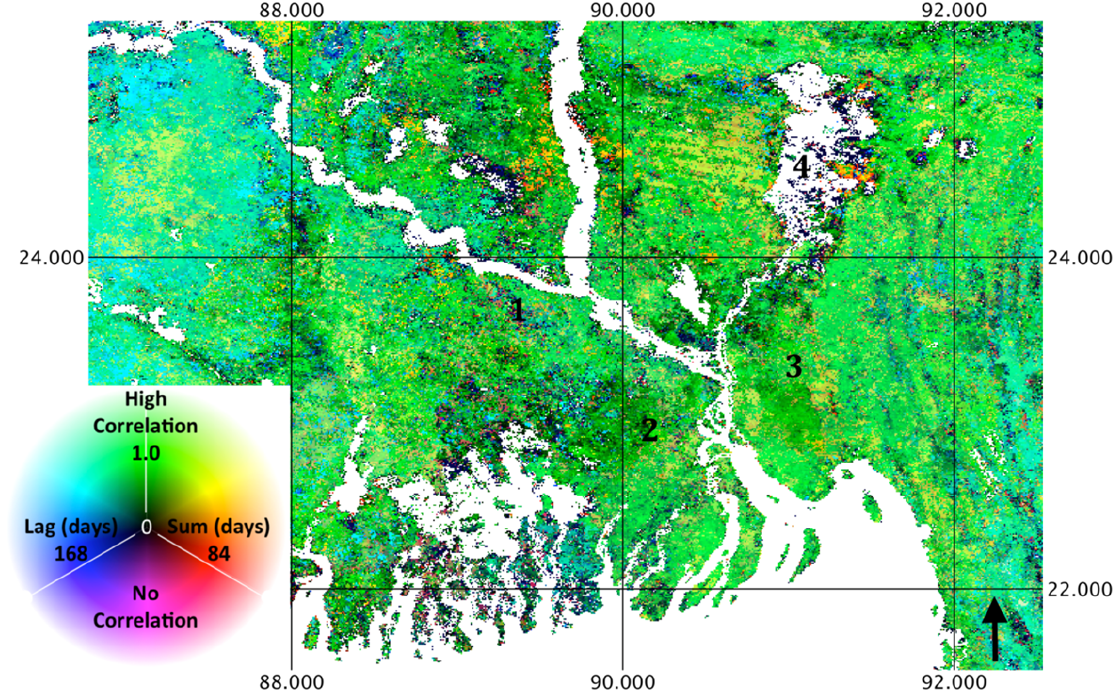
Figure 10. Temperature correlation, lag and summation period illustrating different cropping systems in the Ganges River Delta, Bangladesh. 1-km resolution.